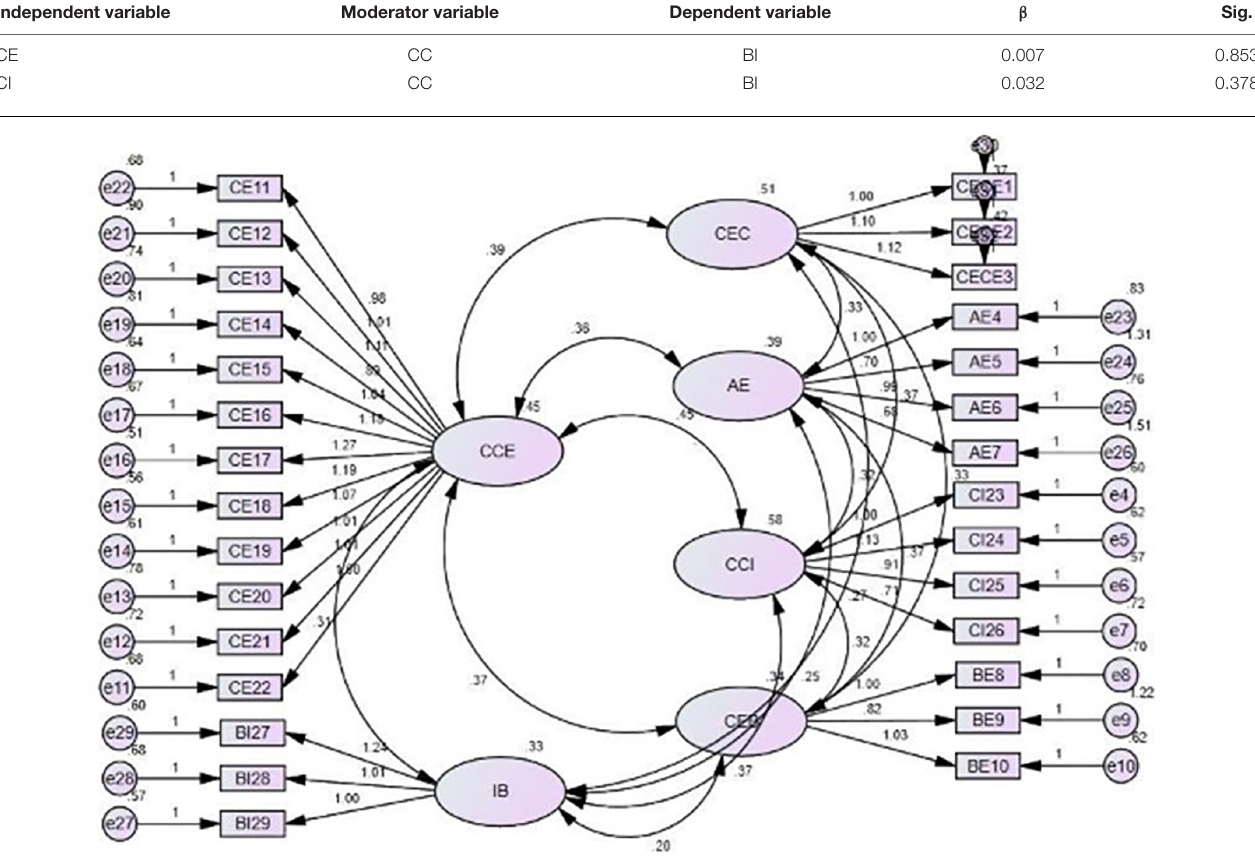
FIGURE 2 | Confirmatory factor